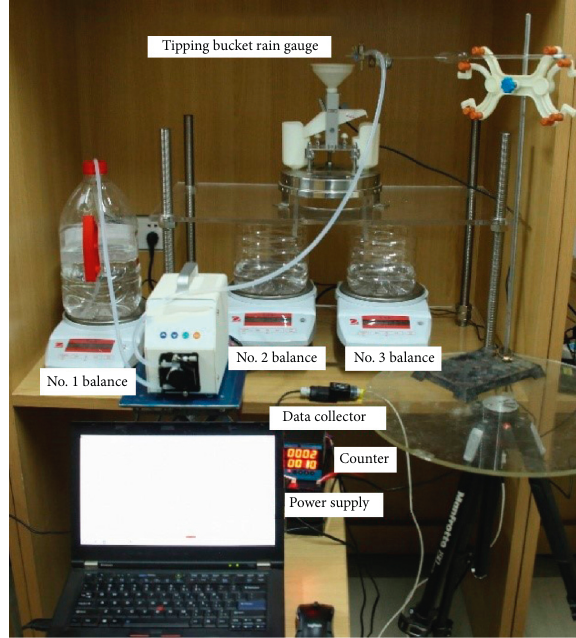
Figure 3: Calibration